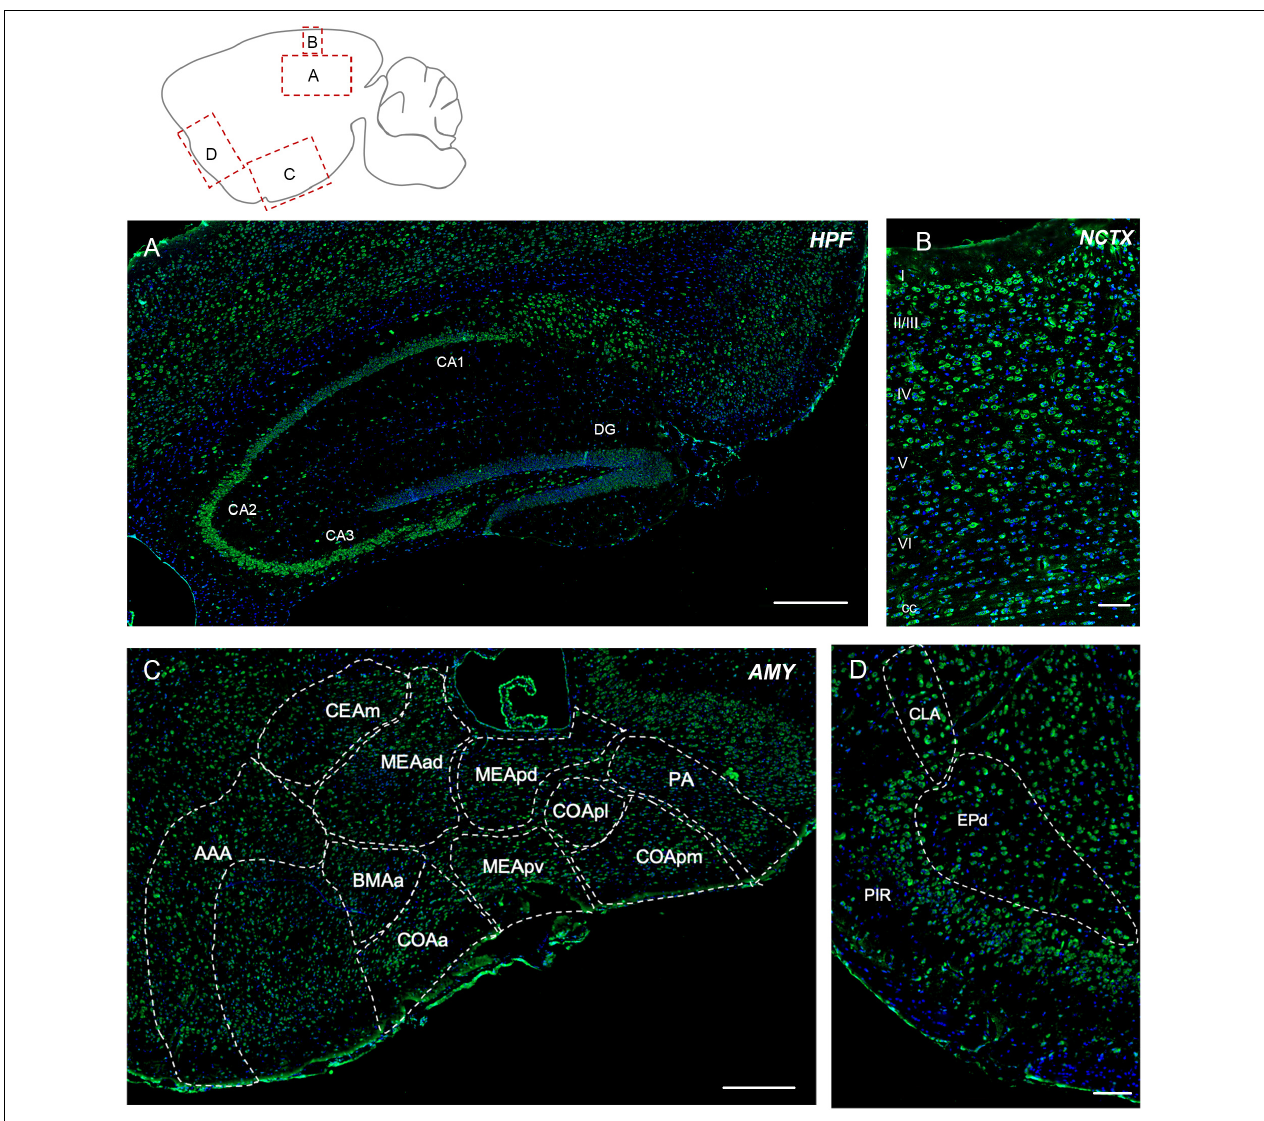
FIGURE 3 | Elovl5 expression in cortical and subcortical regions. (A) In the hippocampus, Elovl5 (green) is strongly expressed by CA2 and CA3, in a moderate way by CA1, while it is not present in dentate gyrus. Oriens, radiatum, and hilar interneurons are strongly labeled. Cell nuclei are counterstained by DAPI (blue). (B) In the neocortex Elovl5 labeling is present in a moderately strong way in layers II/III, IV and V. In layer VI, neurons display a weak intensity staining. (C) In the amygdala Elovl5 expression is more prominent in the cortical areas than in medial ones. (D) The claustrum is moderately positive for Elovl5 staining, while piriform and endopiriform cortex show a strong signal. HPF, hippocampal formation; CA, Cornu Ammonis; DG, dentate gyrus; NCTX, neocortex; AMY, Amygdala; AAA, Anterior amygdalar area; CEAm, Central amygdalar area, medial part; MEAad, Medial amygdalar area, anterodorsal part; MEApd, Medial amygdalar area, posterodorsal part; MEApv, Medial amygdalar area, posteroventral part; COApl, Cortical amygdalar area, posterior part; COApm, Cortical amygdalar area, posterior part, medial zone; PA, posterior amygdalar nucleus; BMAa; Basomedial amygdalar nucleus, anterior part; PIR, piriform cortex; CLA, claustrum; EPd, endopiriform nucleus, dorsal part. Scalebars: (A) 500 µ m, (B,D) 100 µ m, and (C) 250 µ